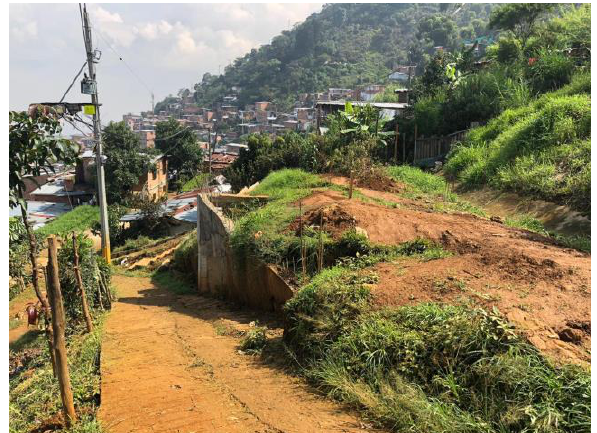
Figure 2. Photograph of the east side of the Aburrá valley. It shows the vertical profile of one slope from another slope (This Photo was made by the Team of the Technical University Munich in April